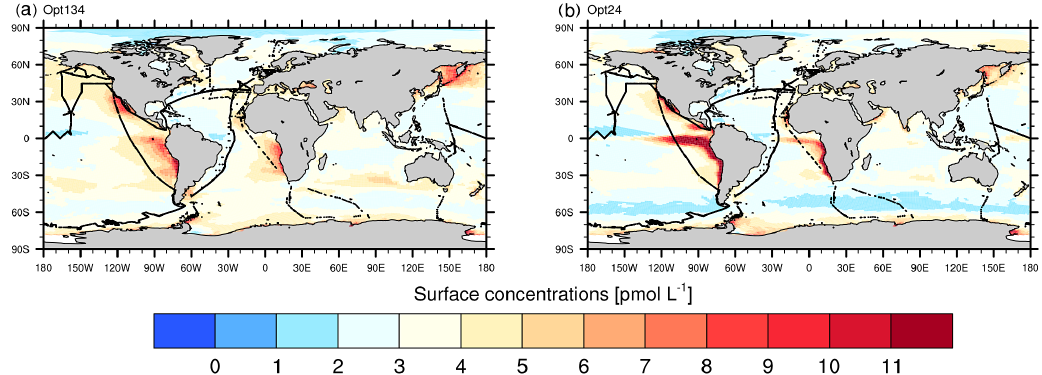
Figure 7. Methyl iodide concentration (pmolL − 1 ) in the experiment with mixed biological and photochemical production, Opt134 (a) , and the one with mixed biological production considering stressed picocyanobacteria and photochemical production from RDOC, Opt24 (b) . Black dots mark the sampling locations of the CH 3 I observations (shown in Fig.